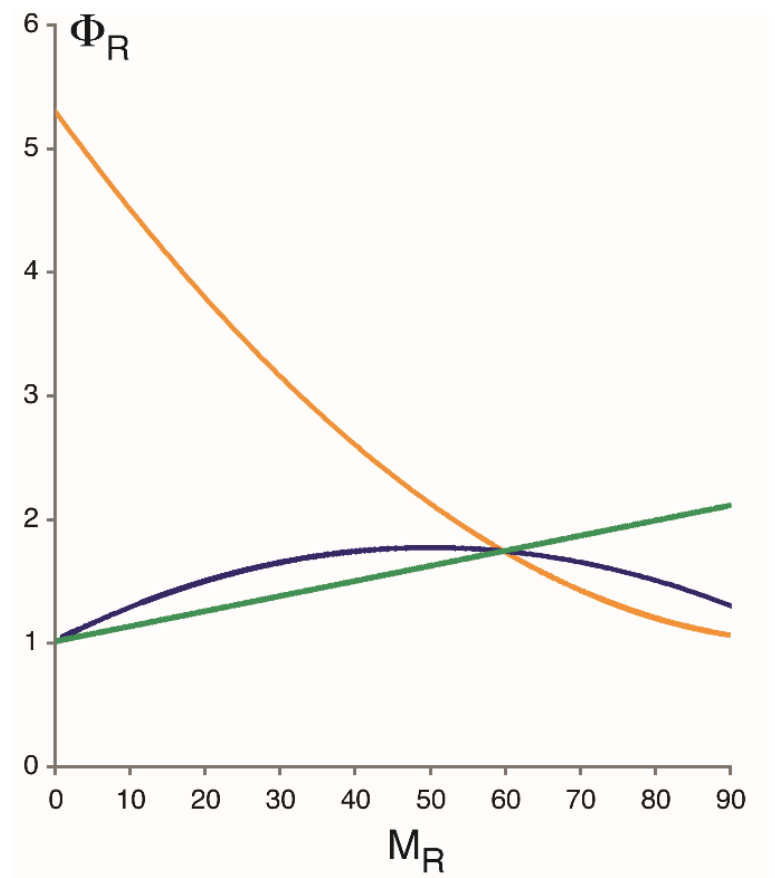
Figure 3. Fano factor for RNA expression, Φ R , as a function of average transcript number, M R . (Likewise, the ‘ unit ’ of Φ R is number of mRNA molecules.) Curves were calculated on the assumption of a stationary Markov process with two promoter states (Figure 2A), with transcription controlled either by tuning α (burst frequency, yellow curve), β −1 (burst duration, blue curve), or ε (the initiation rate of transcription in the ON state, green curve). See main text for equations. The parameters for M R = 60 are ε = 6.75 per minute, α = 2.18 per minute, β = 1.5 per minute, and δ = 0.066 per minute and molecule [4]. In the absence of transcriptional bursting, Φ R invariably equals